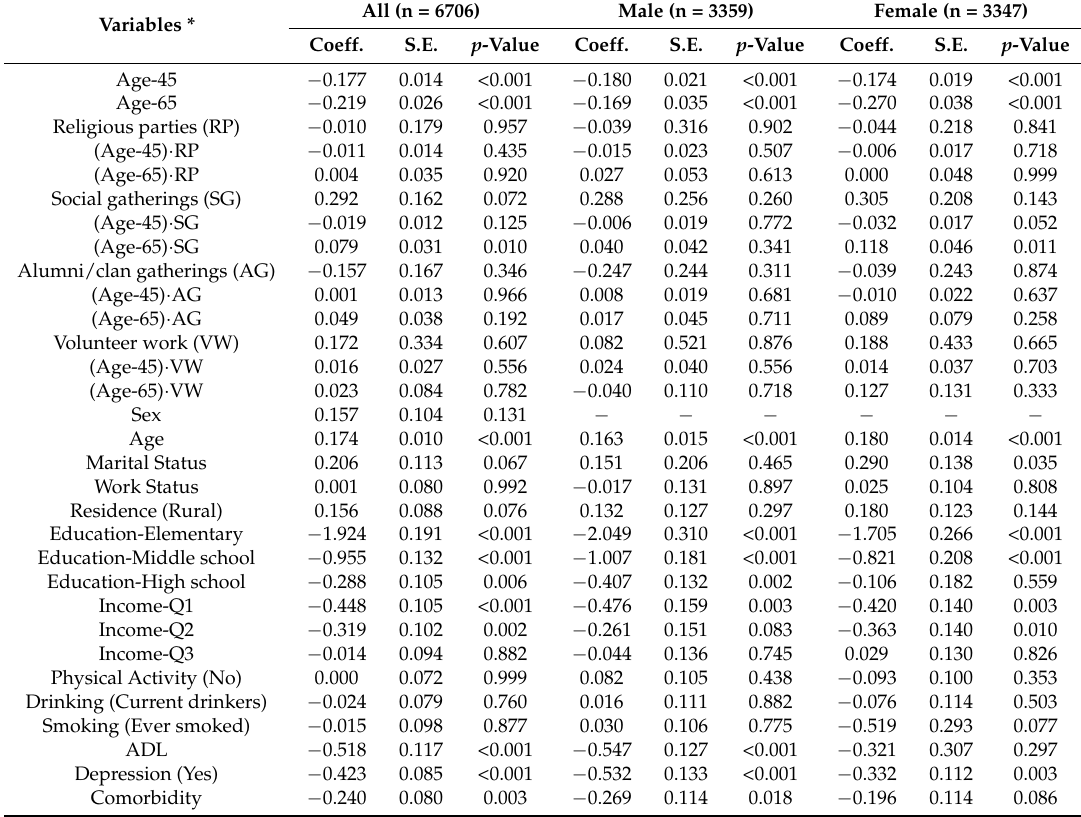
Table 2 . Relationship between social activity and cognitive performance from the Korean Longitudinal Study of Aging (KLOSA), 2006 – 2014 (n = 6706).